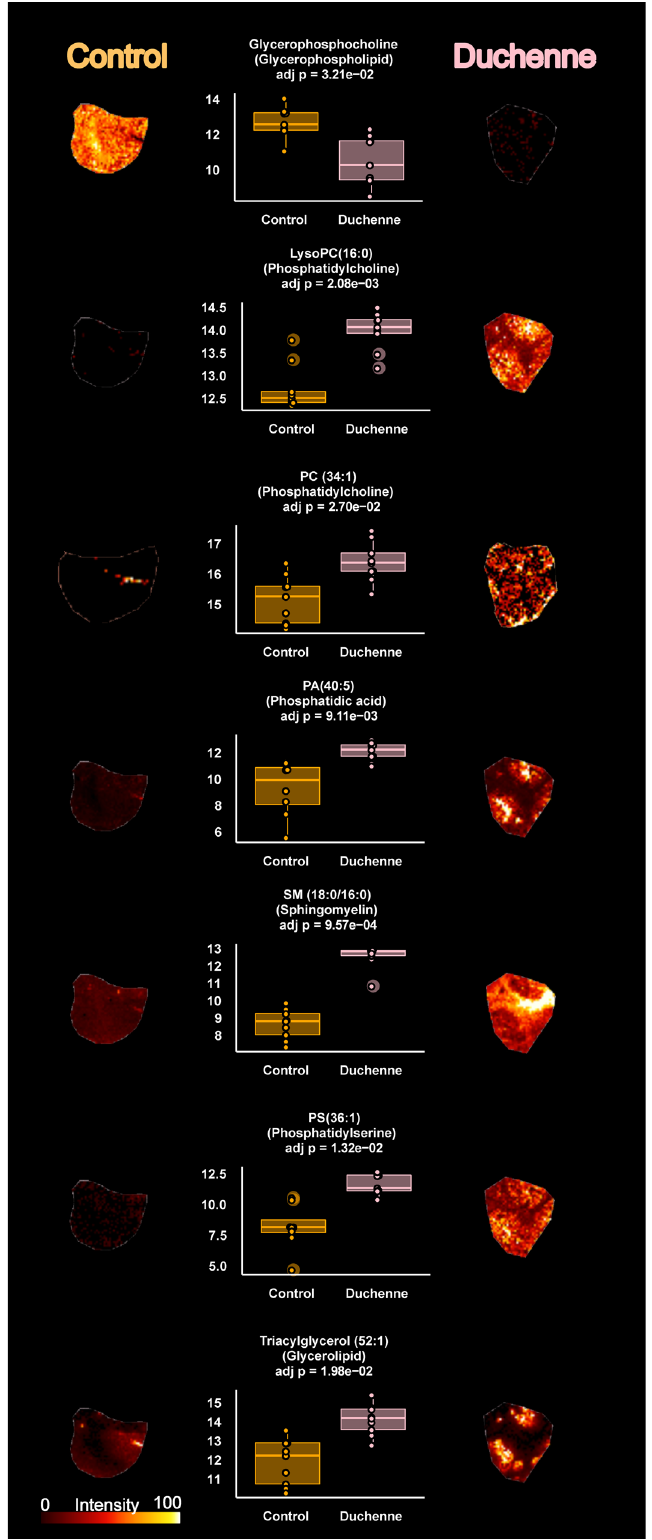
Figure 3. Tissue distribution of selected discriminant metabolites. Left) Tissue metabolite distribution in the control tissue. Right) Tissue metabolite distribution in the DMD tissue. Middle) Boxplot of the selected metabolites between DMD and control tissues with related adjusted p-values. The y-axis shows the log-scaled average intensity. Ion images were generated using SCiLs Lab